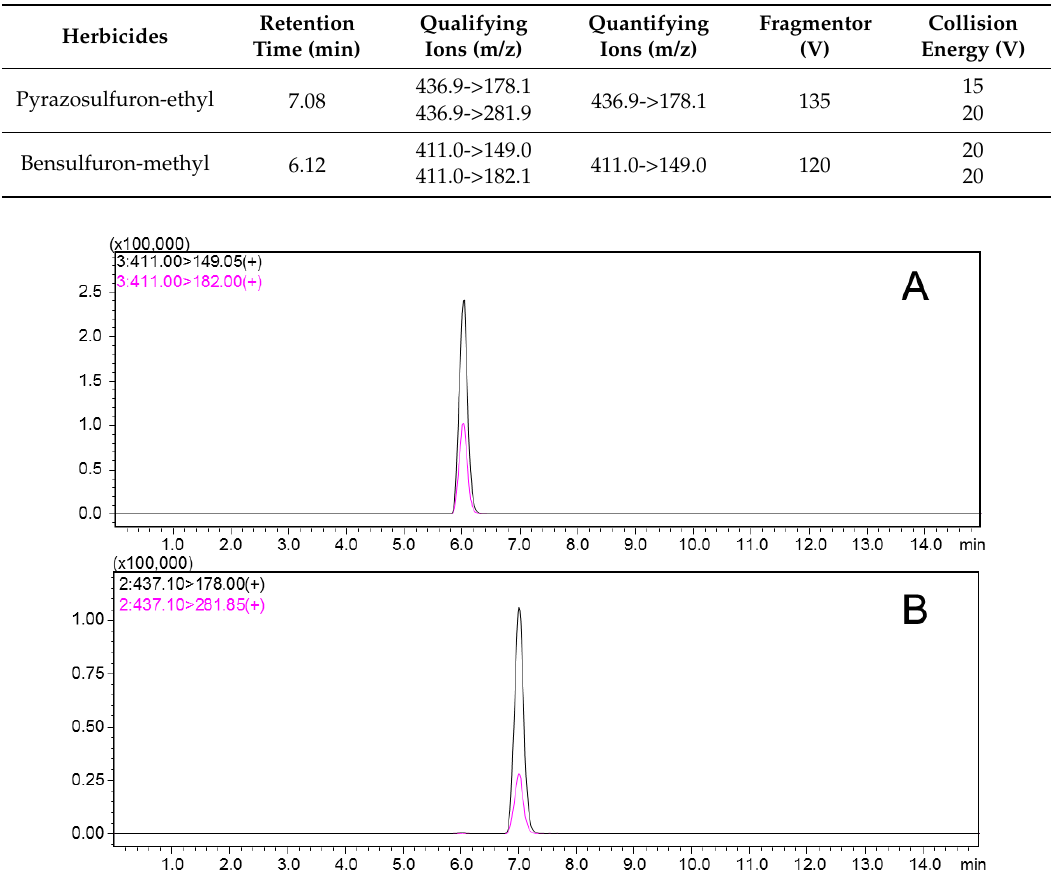
Figure 2. The LC-MS/MS chromatograms of pyrazosulfuron-ethyl ( A ); bensulfuron-methyl ( B ) standards in multiple reaction monitoring (MRM) mode.